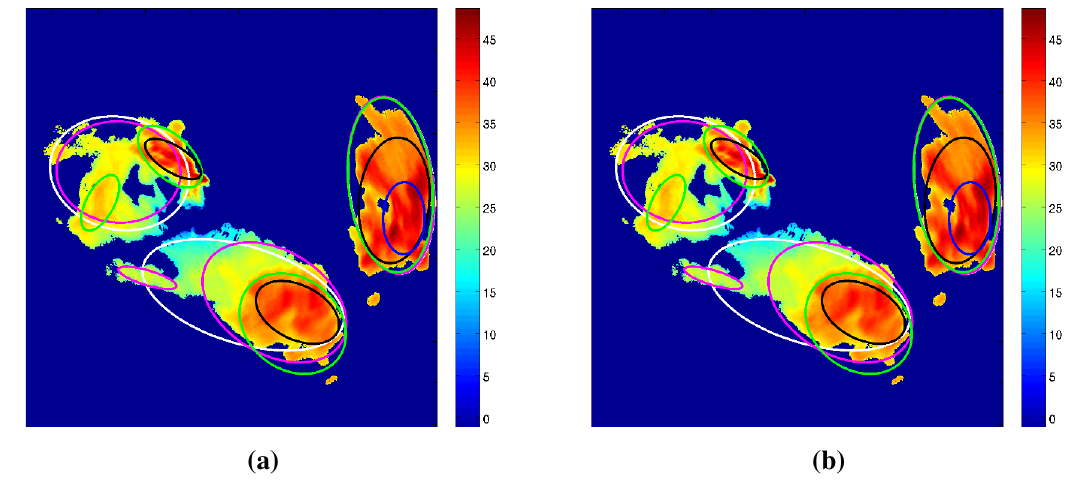
Figure 7. Multi-threshold storm identification. ( a ) ThreshGW; ( b )